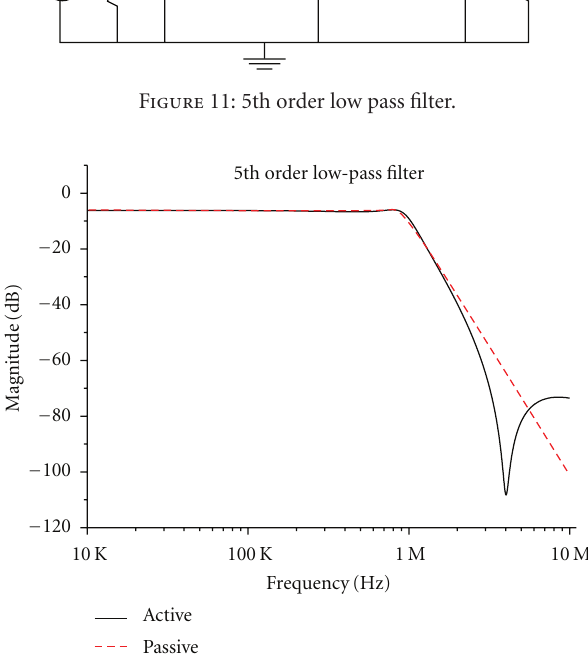
Figure 12: Magnitude response of 5th order